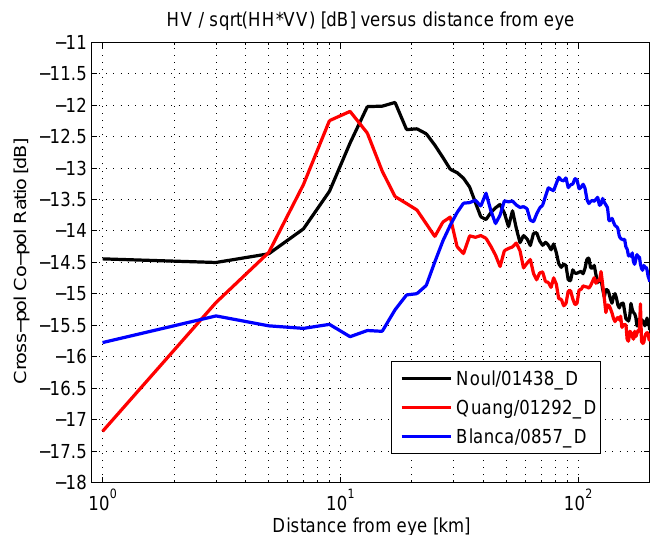
Figure 3. Ratio of the HV σ 0 to the geometric average of the HH and VV co-polarization σ 0 plotted as a function of distance from estimated hurricane eye location for Noul (black), Quang (red), and Blanca (blue). The cross-pol co-pol ratio seems to peak at − 12 dB for extreme winds and decreases as wind speed decreases. The Aquarius GMF indicates − 16.6 dB ratio at 7.5 m/s wind speed. Note that Blanca, while weaker, is spatially a much larger storm with a larger eye, has two peaks (in agreement with the wind fields), and does not reach as high of a cross-pol co-pol ratio as the other two storms (less